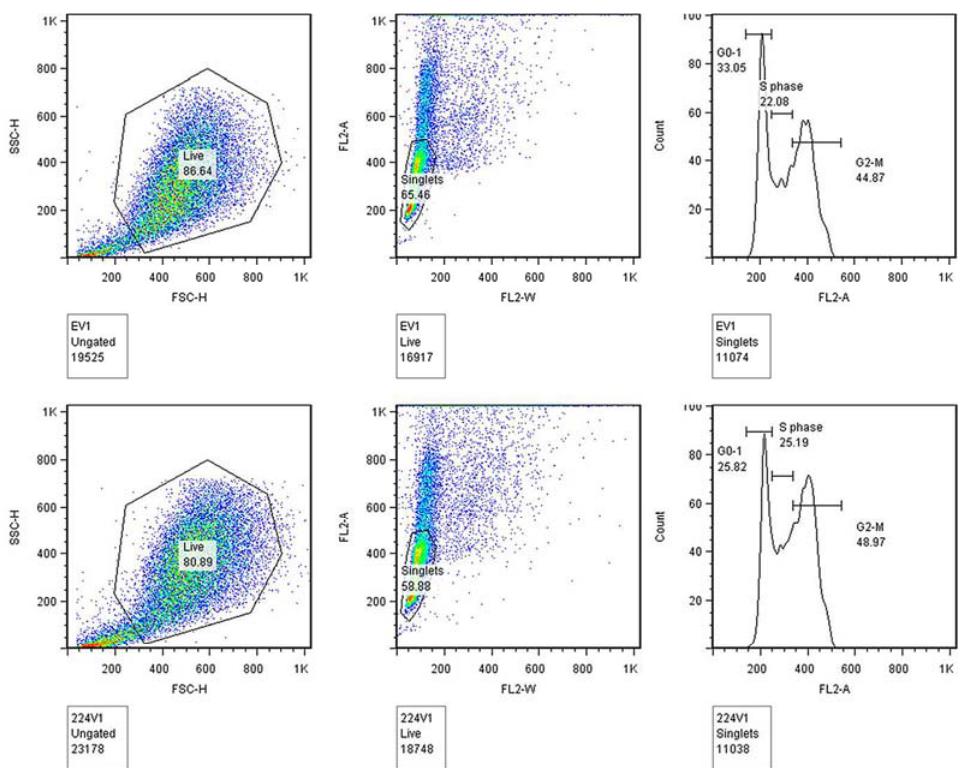
Figure 4. HuCCT1 cells display G1 release upon reinforced miR-224 expression. Flow cytometric analysis of cell cycle via PI staining of HuCCT1 cells infected with MIEG3-miR-224 (224V, lower panels), or MIEG3 only (EV, upper panels). X-axis: DNA content as measured by PI incorporation; y-axis: cell counts for each phase of the cell cycle. The figure is representative of three experiments with three replicates per experiment.